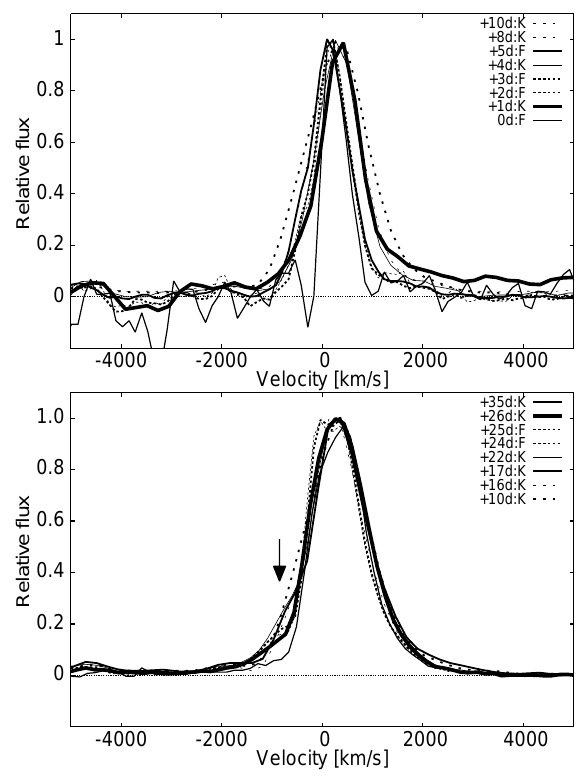
Figure 3: Temporal change of H α emission line before and after the brightness maximum at t=17d after the outburst (upper and lower panels, respectively). The line widths became broader at later dates. The black arrow in the lower panel shows the change in blue-shift component that could have been caused by the change in the velocity structure of the ejected materials. Based on the light curves shown in Figure 2, nova V1724 Aql showed very slow evolution in brightness af- ter the outburst until its brightness maximum in the V - band (t=17d, V =13.6 ± 0.2 mag). The visual brightness was almost unchanged (but oscillating with small ampli- tude) until the brightness maximum since the outburst (14.4 ± 0.4 mag in V -band). The evolution in bright- ness was slow for V1724 Aql in earlier phase. However, after the brightness maximum (t=17d), its brightness in V -band become fainter with a decline rate of